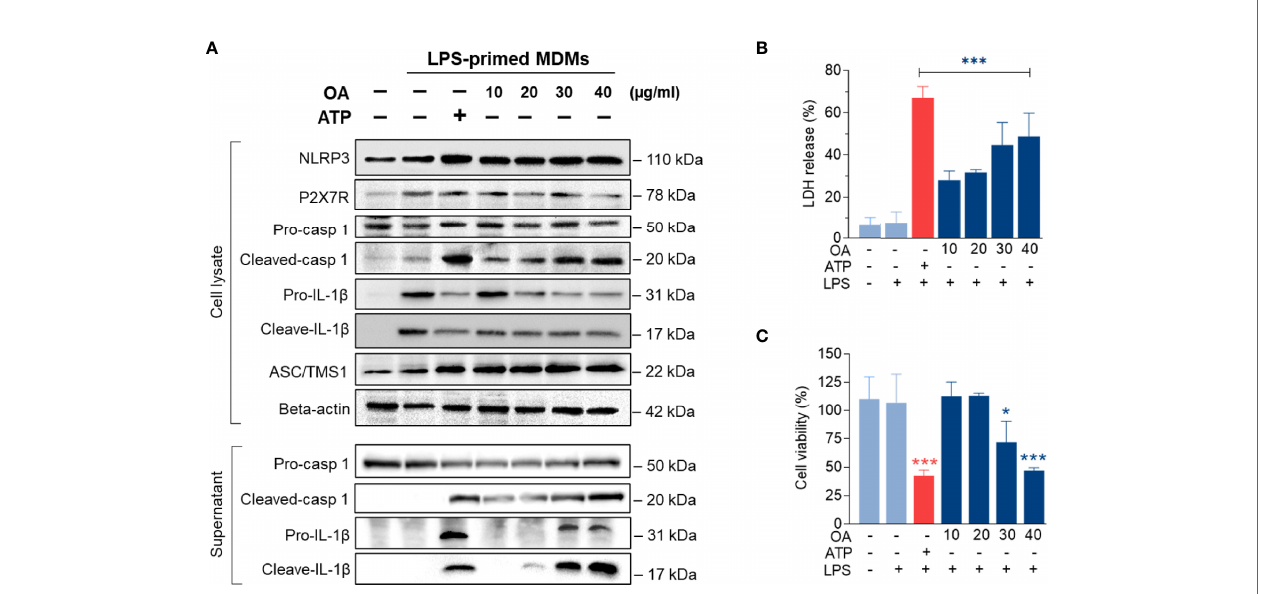
FIGURE 5 | Oleamide promoted NLRP3 in fl ammasome activation in LPS-primed MDMs. (A) Western blot of whole cell lysate and supernatant from LPS-primed MDMs treated with oleamide (OA) (10 - 40 µg/ml) or ATP (30 mM) for 3 h (B) Release of LDH and (C) Cell viability (%) in LPS-primed MDMs treated with OA (10-40 µg/ml) or ATP (30 mM) for 3h Data represent the mean ± SEM of three independent experiments (*p < 0.05, ***p < 0.001). LPS, lipopolysaccharides; ATP, adenosine triphosphate; OA, oleamide; LDH, lactate dehydrogenase; ASC, apoptosis-associated speck-like protein containing a C-terminal caspase recruitment domain; NLRP3, NOD-, LRR- and pyrin domain-containing protein 3; P2X7R, purinergic P2X7